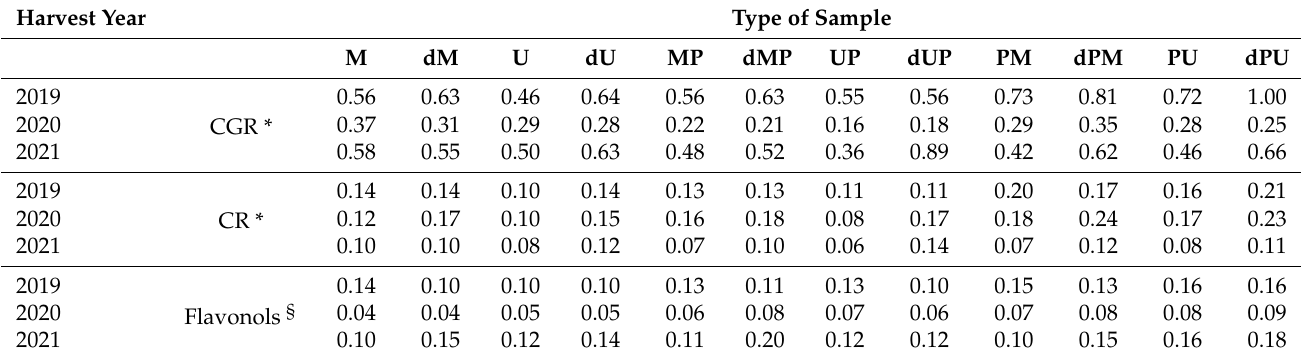
Table 2. Quantitative HPLC-DAD data of the selected samples, expressed as mg/g fresh weight. Type of